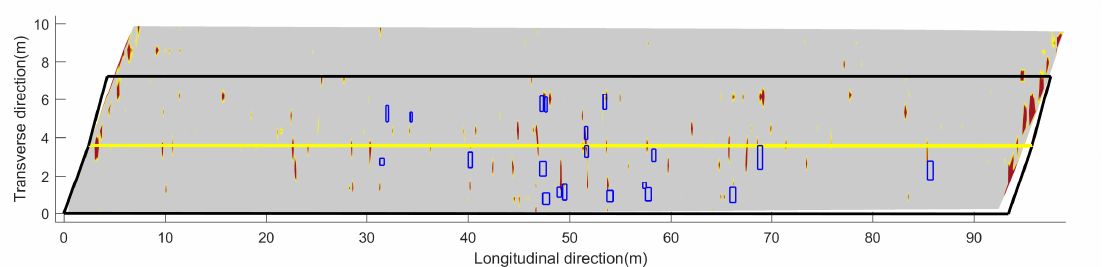
Figure 11. Combined results of acoustic scanning and GPR